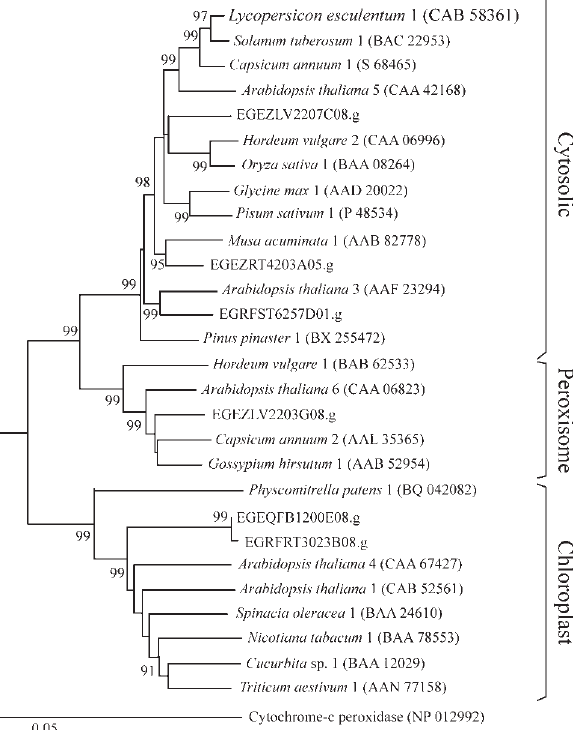
Figure 4 - Phylogenetic tree of APx proteins. Phylogenetic analyses were conducted as described in Figure 2.